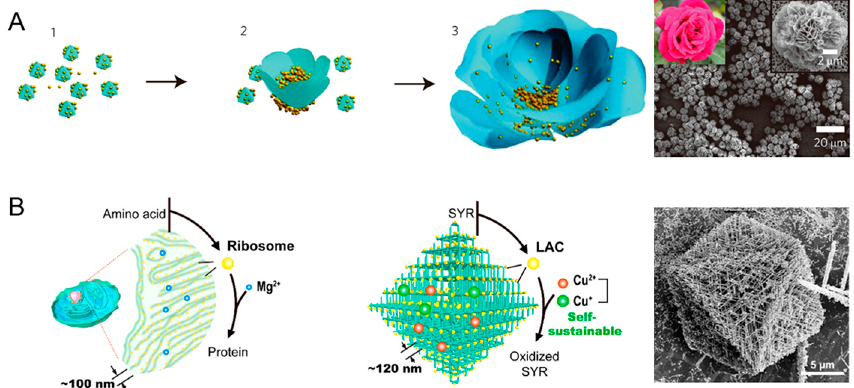
Figure 4. ( A ) Formation process of enzyme-incorporating Cu 3 (PO 4 ) 2 · 3H 2 O nanoflowers, comprising